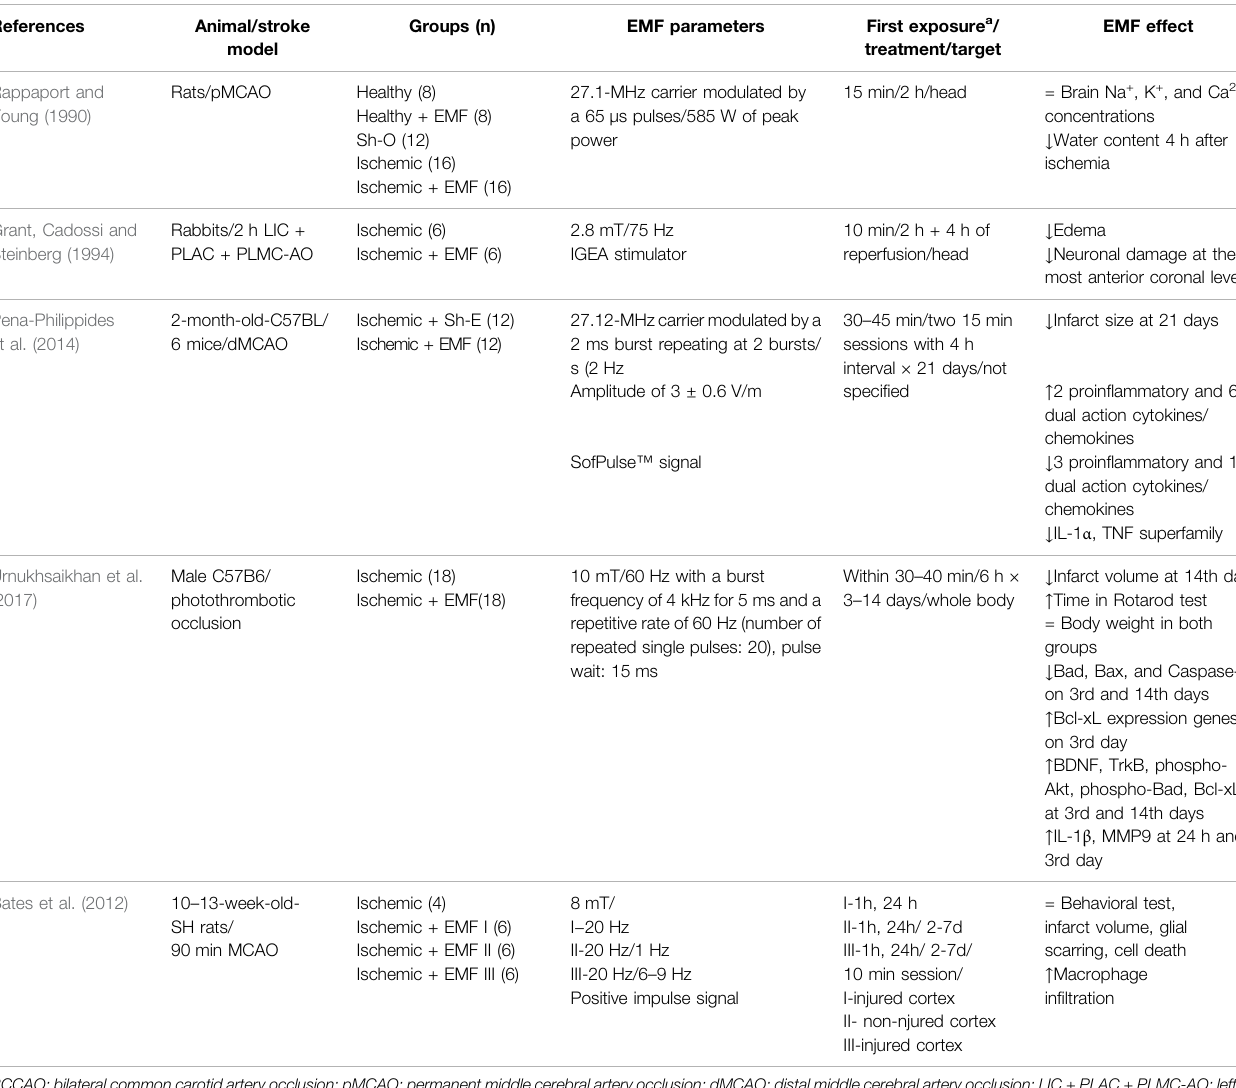
TABLE 2 | Overview of in vivo studies using pulsed electromagnetic fi eld (PEMF) as a treatment for ischemic